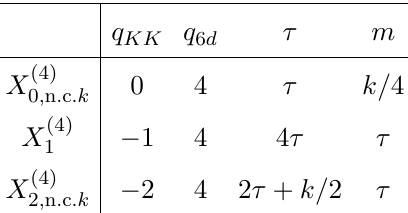
Table 12 . The restrictions of Kähler parameters that correspond to the Higgs transitions in figure 8. The choices of B-fields follow from the analysis in section 5.4.